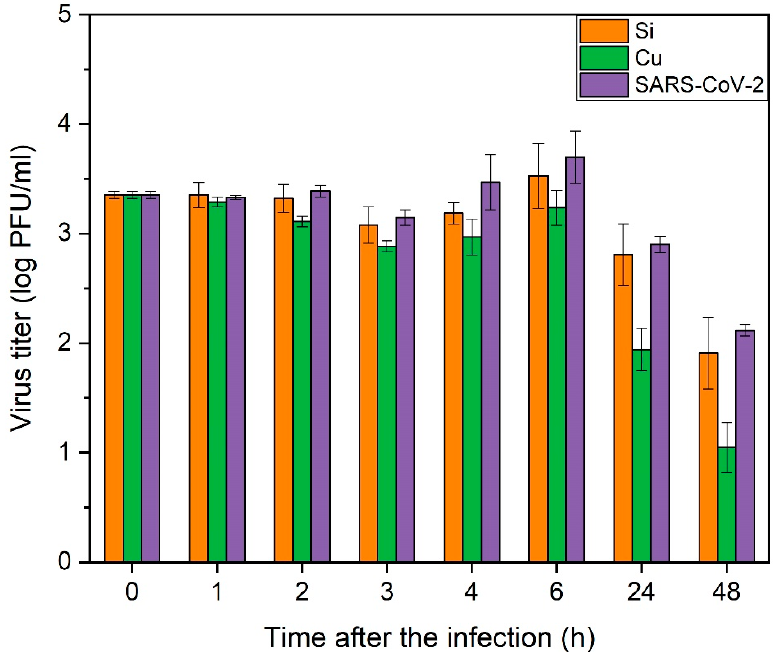
Figure 10. Antiviral effect of pure copper coating against SARS-CoV-2. Si was chosen as the negative control, which is shown by orange color.